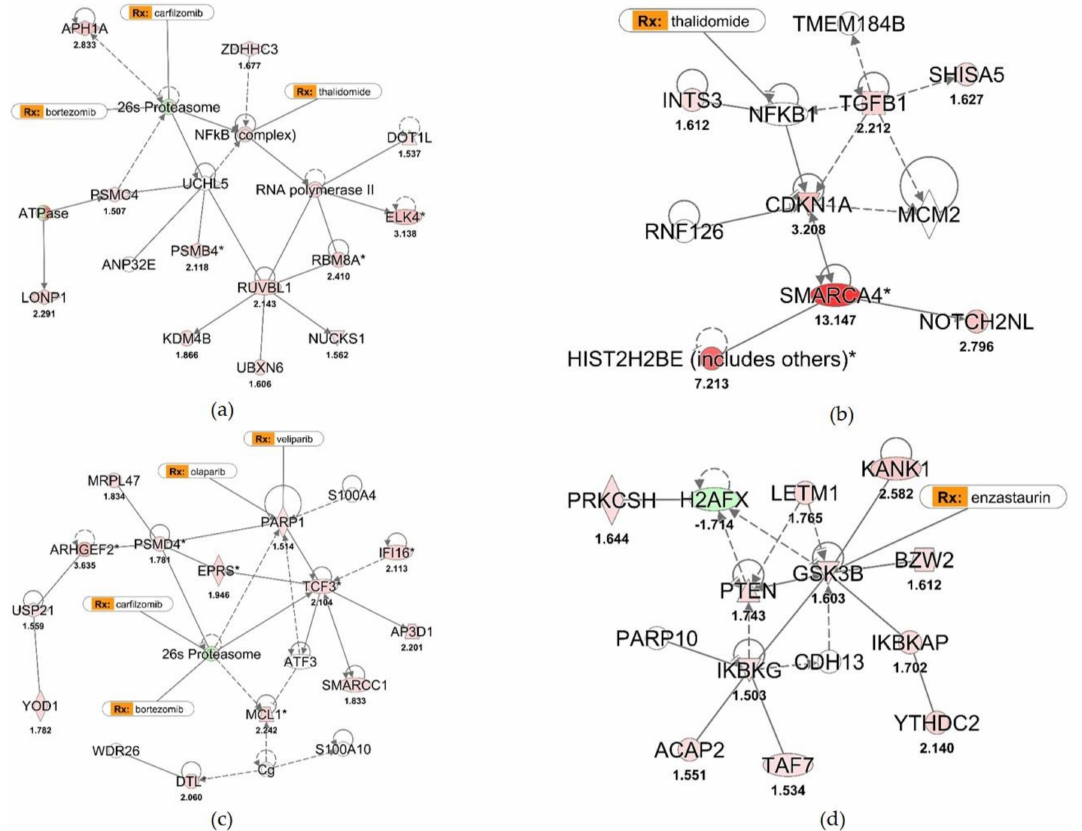
Figure 6. Subgroup Expression Networks are Easily Targeted with Existing Therapeutics. In-depth analysis of protein networks, unique to individual or a small number of myeloma subgroups, to identify novel therapeutic regiments for myeloma. ( a ) NF- κ B, ANP32E and proteasome protein network unique to the MF subgroup. ( b ) NF- κ B and TGF β protein network unique to the MF subgroup. ( c ) PARP1 and 26S proteasome network unique to the MS, MY and PR subgroups. ( d ) GSK3B, PARP10 and PTEN protein network unique to the MY and LB